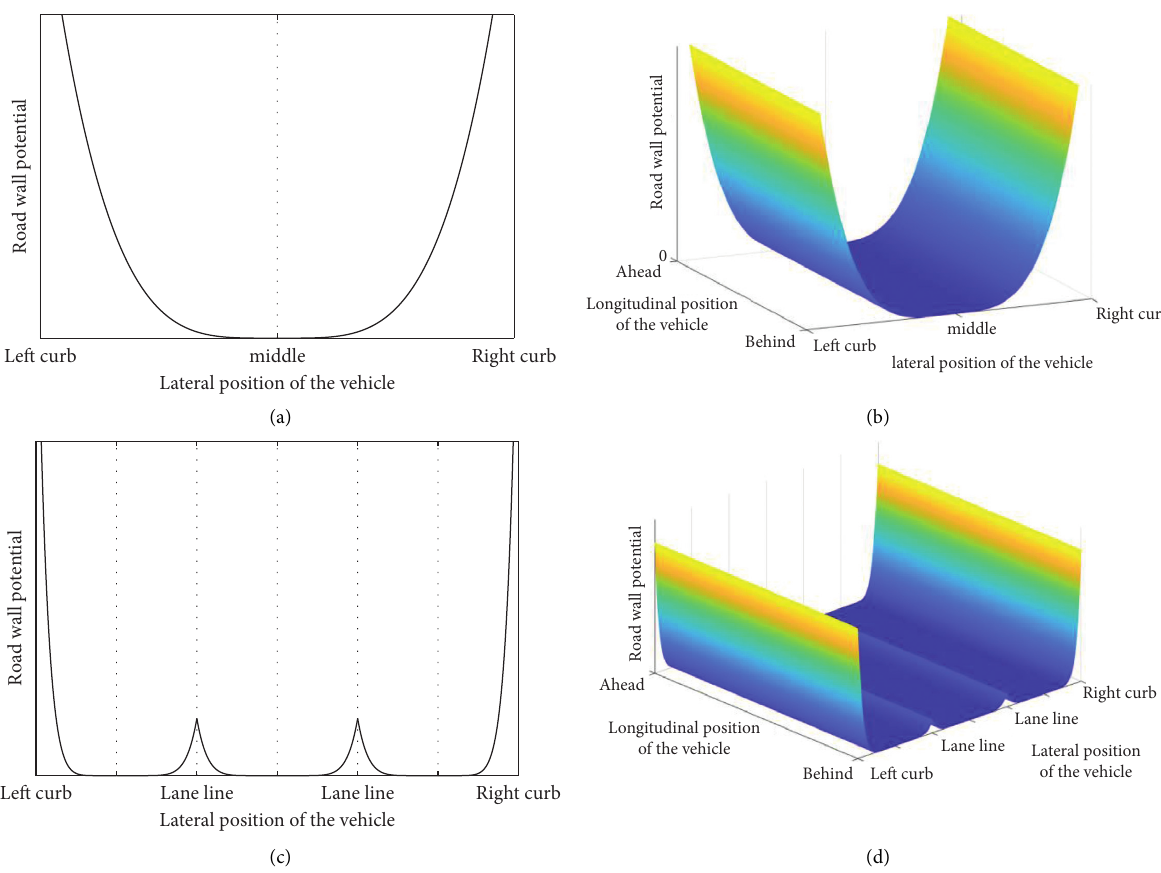
Figure 5: Wall potential. (a) Cross-section of road wall potential of single lane. (b) Single lane road wall potential. (c) Cross-section of a 3- lane road wall potential. (d) 3-lane road wall